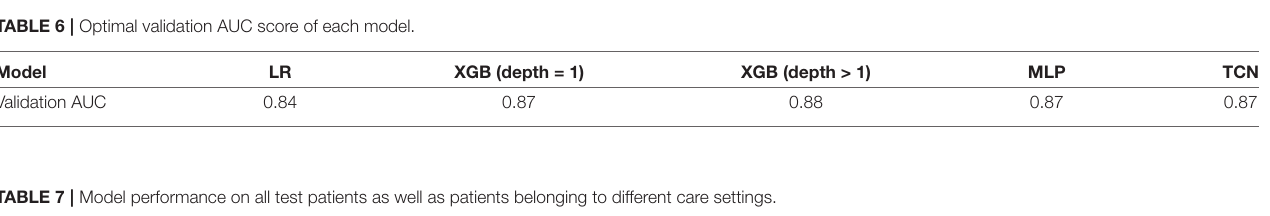
TABLE 7 | Model performance on all test patients as well as patients belonging to different care settings. Care